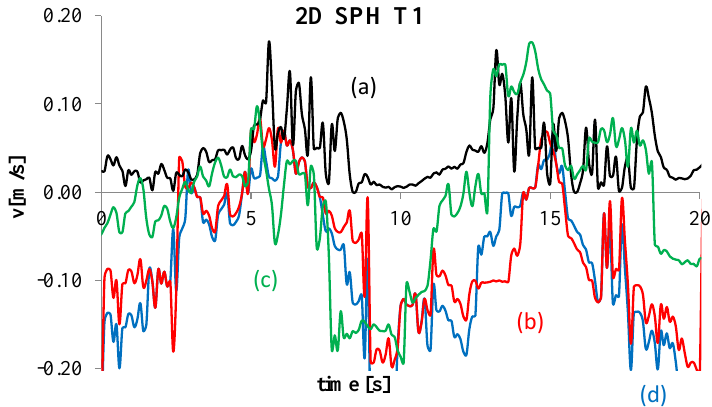
Figure 21. Time series of the vertical velocity component under hydraulic jump (configuration: T1) measured at a distance of: ( a ) 7 cm; ( b ) 10 cm; ( c ) 20 cm; and ( d ) 100 cm, from the time-averaged position of the hydraulic jump toe.